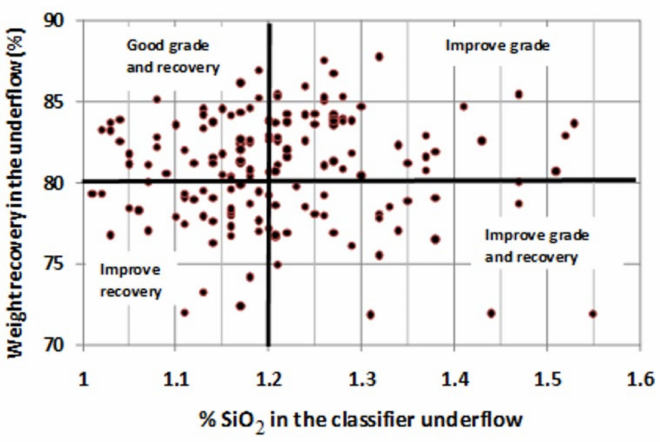
Figure A3. Weight recovery and silica content of the classifier underflow observed for 200 on-stream days of operation [6].